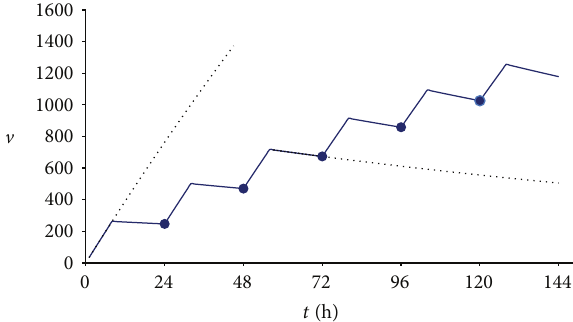
Figure 1: Periodic alternation of learning and forgetting. Vertical axis represents the number of memorized words of a foreign language; horizontal axis represents